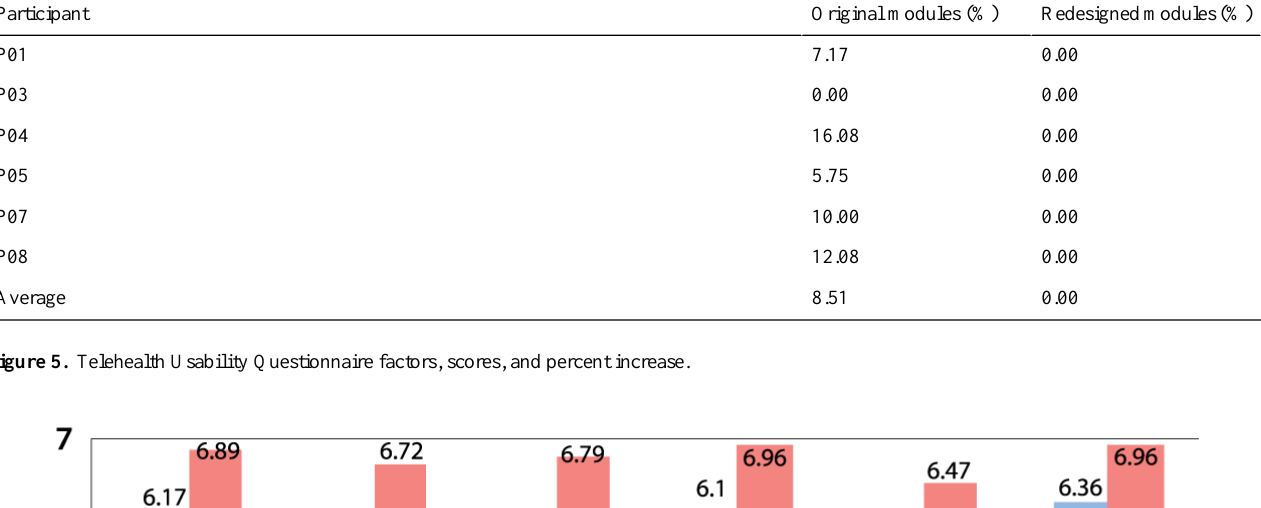
Redesigned modules (%)Original modules (%)Participant